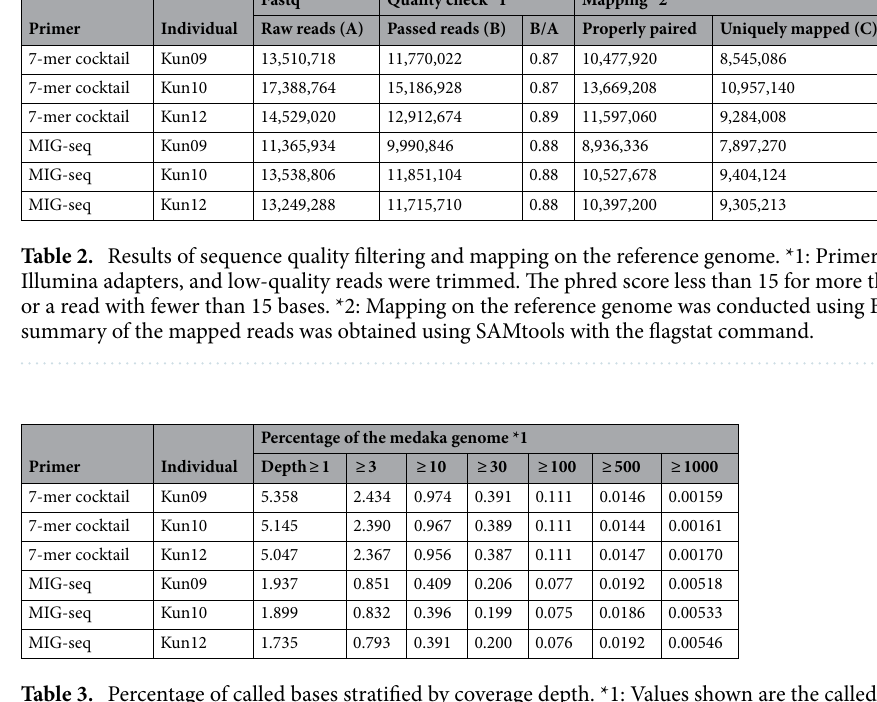
Table 3. Percentage of called bases stratified by coverage depth. *1: Values shown are the called bases divided by the total base number, i.e., 734,040,372 bases, in the medaka genome. Each sample was extracted and adjusted to six million reads from the uniquely mapped reads in the BAM